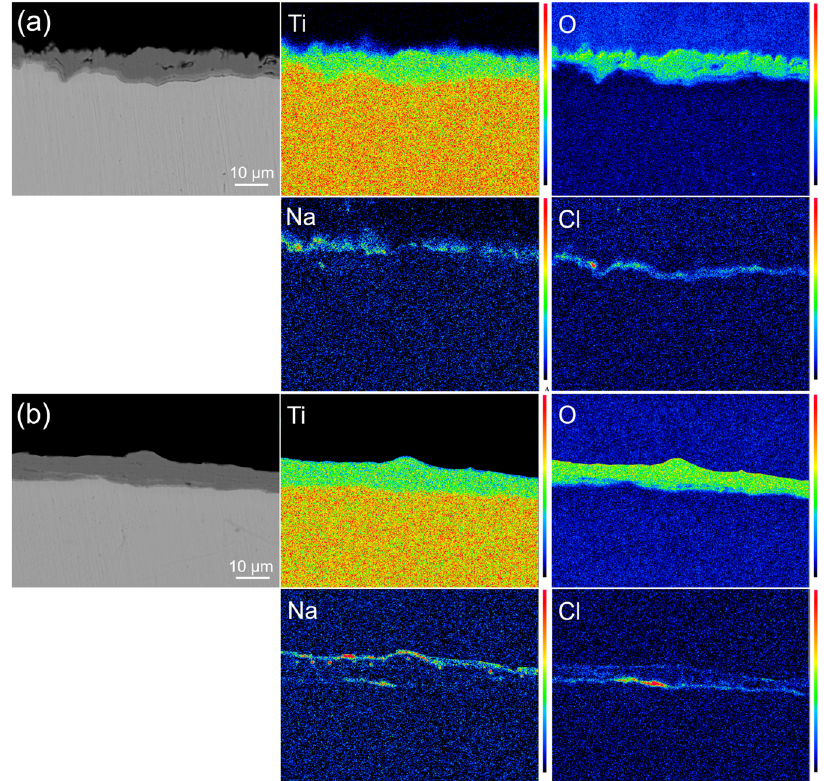
Fig. 9 EPMA elemental maps of corrosion products of pure Ti in continuous NaCl solution spraying at 600 o C for different times. a 5 h and b 20 h.